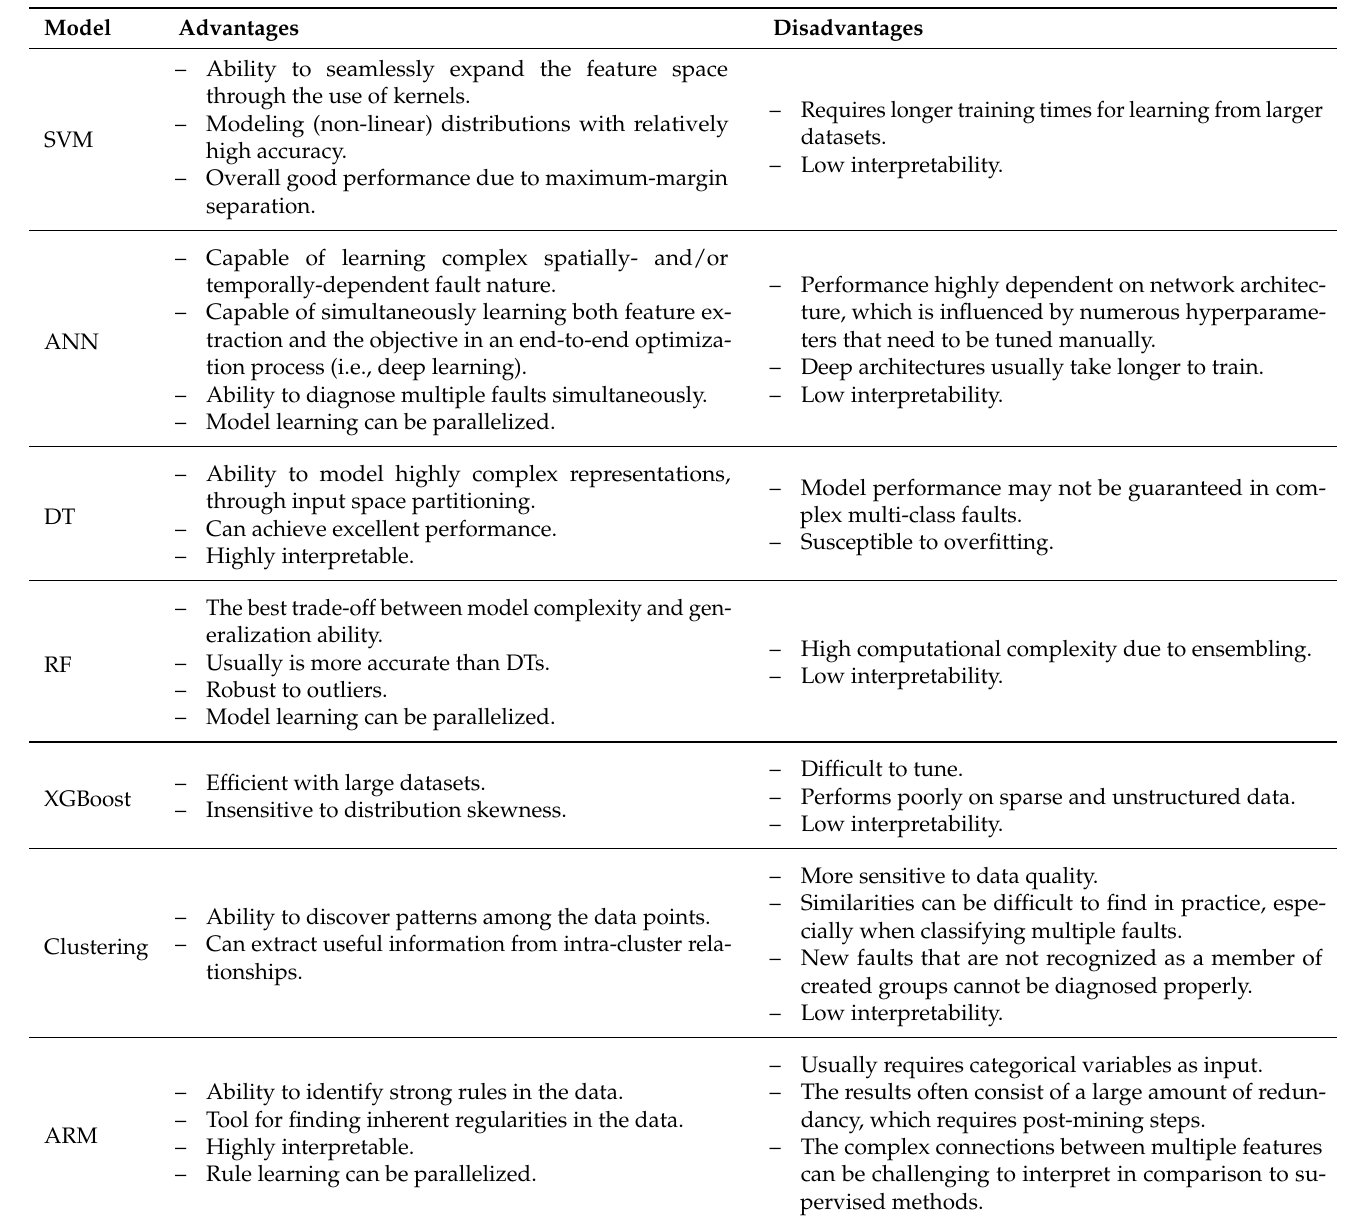
Table 8. A summarized comparison of described ML models in the field of FDD for HVAC systems. While the first five listed models refer to supervised learning, the last two refer to unsupervised learning. For clarity, all acronyms are provided in the Abbreviations